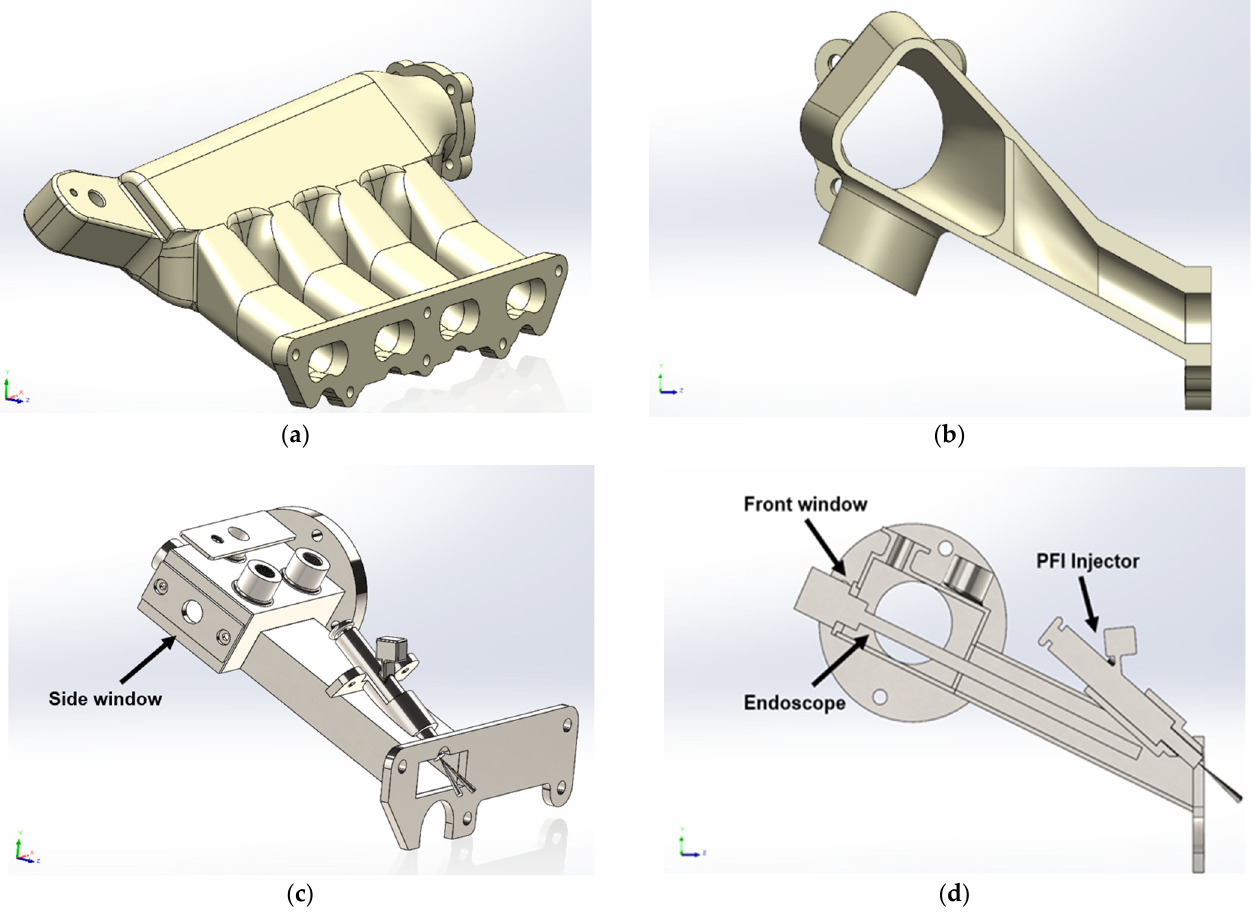
Figure 2. 3D model of the original intake manifold ( a ) and cross-section ( b ). 3D model of the new design ( c ) and related cross-section point of view ( d ).